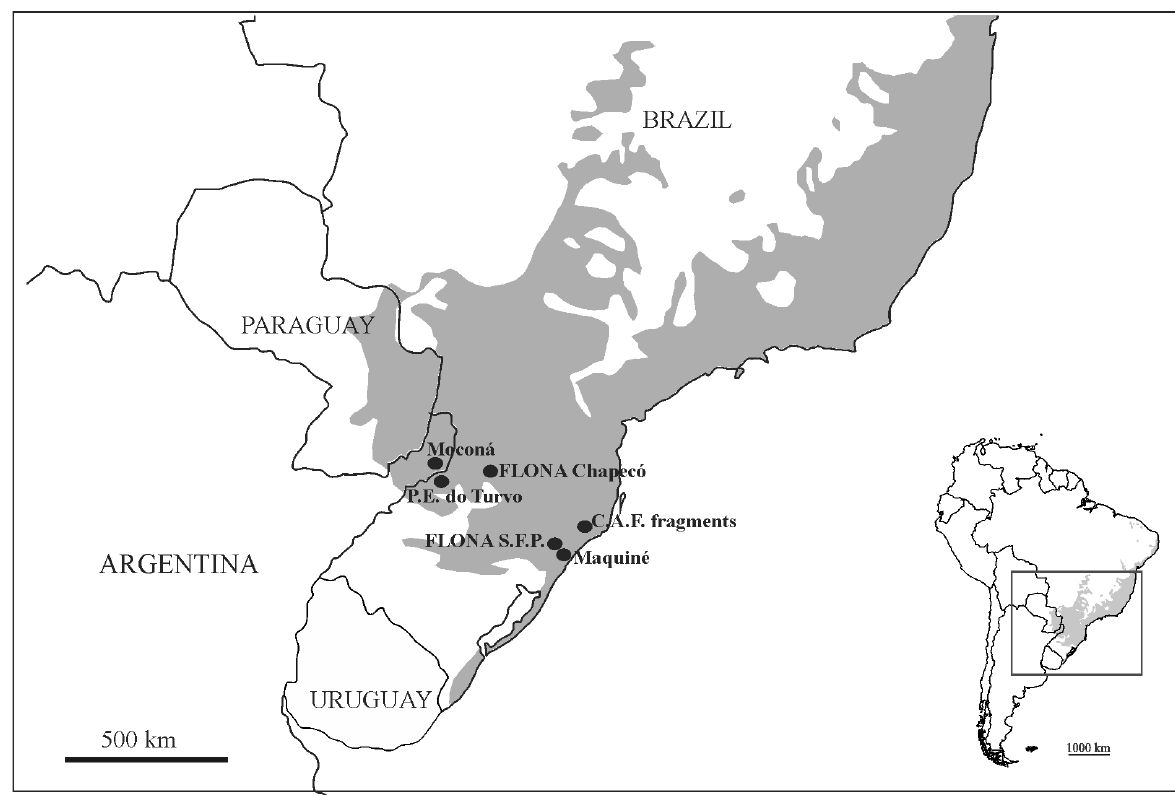
Figure 1 - Location of Parque Provincial Moconá (27˚08′ S/ 27˚11′ S – 053˚53′ W/053˚56′ W) in Argentina, and Brazilian protected areas whose assemblages of Pentatomidae were compared. Grey area represents the original extension of the Atlantic